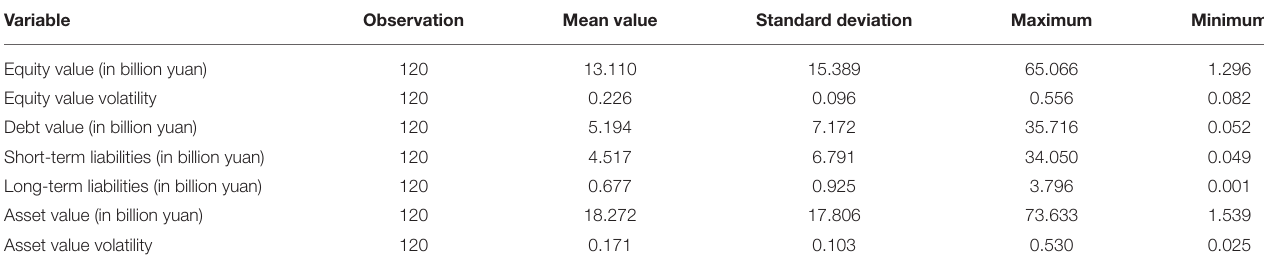
TABLE 1 | Sample related variables and descriptive